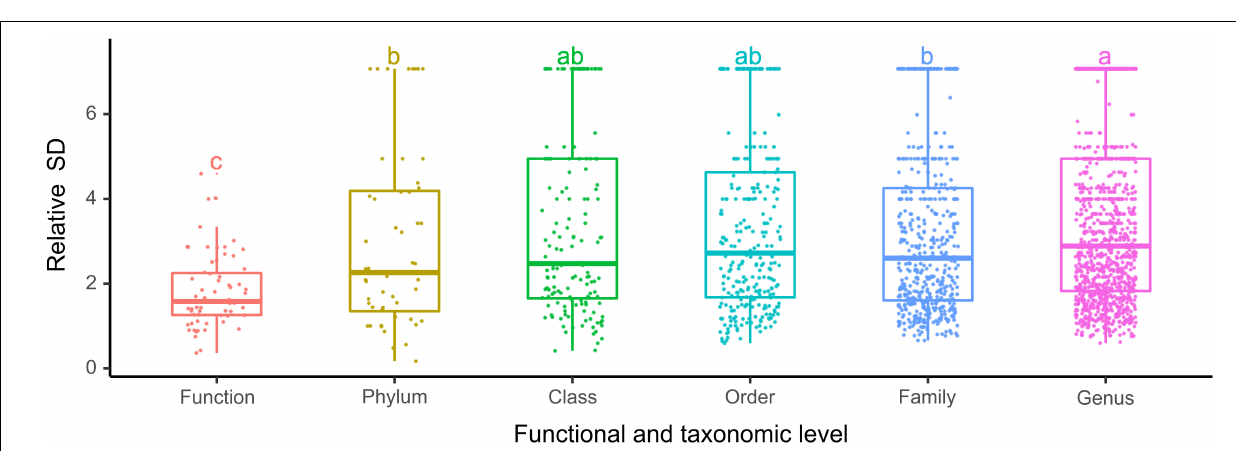
the first principal coordinate ( Figures 4A,B ), and this divergence was further corroborated by Cluster, where the communities from November and April formed separate clusters ( Figures 4C,D ). PERMANOVA of pairwise dissimilarities between bacterioplankton communities indicated that seasonal ( Table 1 ). Although the latitude and offshore distances also not exhibit a regular or obvious spatial pattern ( Figures 4A,B